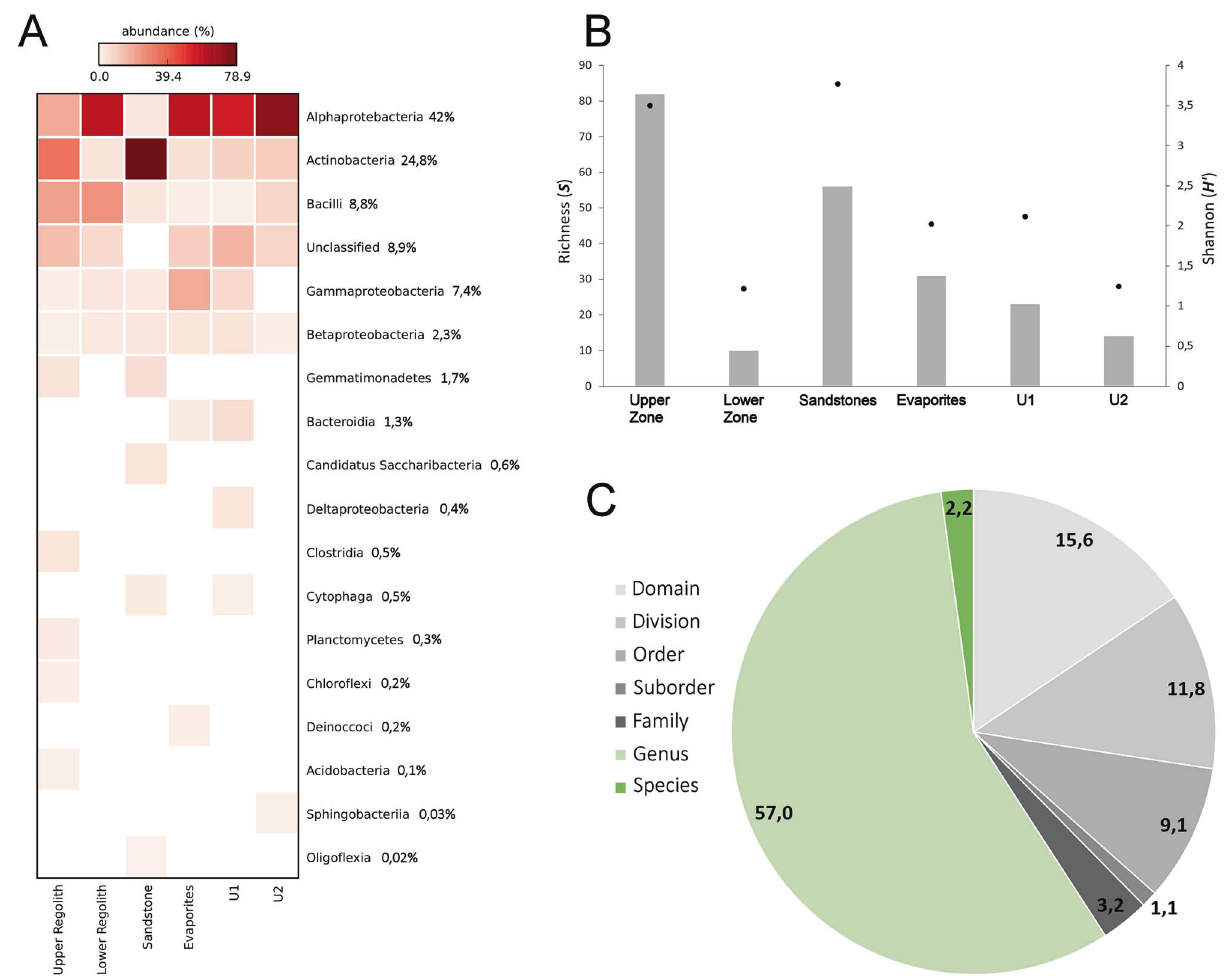
Fig. 4 | Next-Generation Sequencing (NGS) characterization of Red Stone samples. A Heatmap of major bacterial phyla determined by NGS. Numbers representpercentagesoftotalsequences.Thecolorintensityineachboxindicates the relative percentage of each phyla. B Richness (S, bars) and Shannon diversity